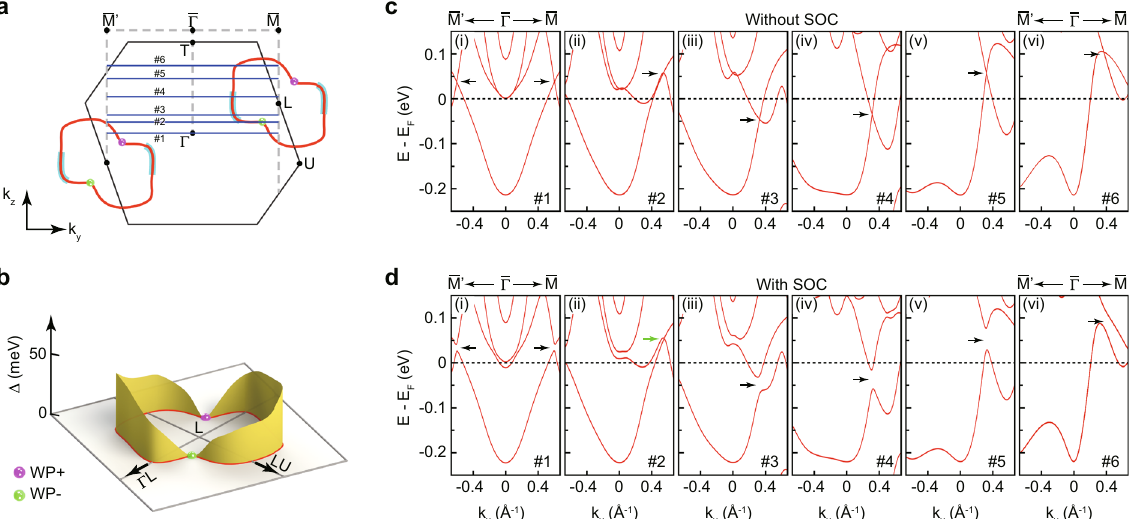
Fig. 2 The calculated band dispersions without and with SOC. a Illustration of the nodal line and Weyl points in one mirror plane. The cyan region of the nodal line represents the SOC-induced gap structure lying below E F . b The calculated SOC-induced gap size along the nodal line. c The calculated band dispersions through the nodal line without SOC effect. Their momentum positions are shown by the blue lines in ( a ). The black arrows illustrate the nodal points along the nodal line. d The corresponding calculated band dispersions of ( c ) with SOC. The black arrows illustrate the gap opened by the SOC effect. The green arrow in (ii) illustrates the Weyl point. The calculated bandwidth was renormalized by a factor of 1.43 and the energy position was shifted to match the experiments.